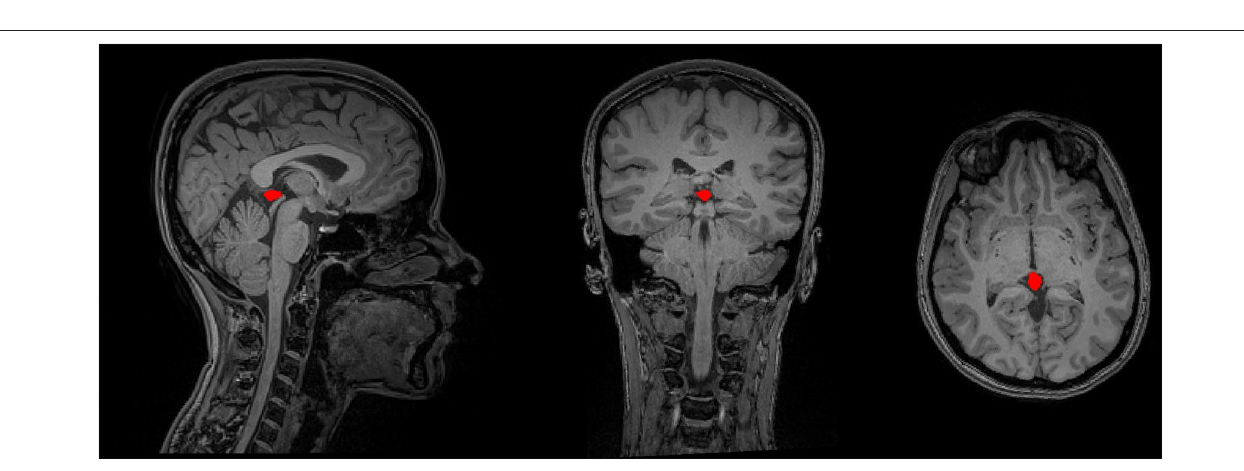
(RMS) values were obtained, or in other words, the averaged template converged ( A n ≈ A n − 1 )]. The last reference model was then introduced as the final template, which is illustrated in Figure 3